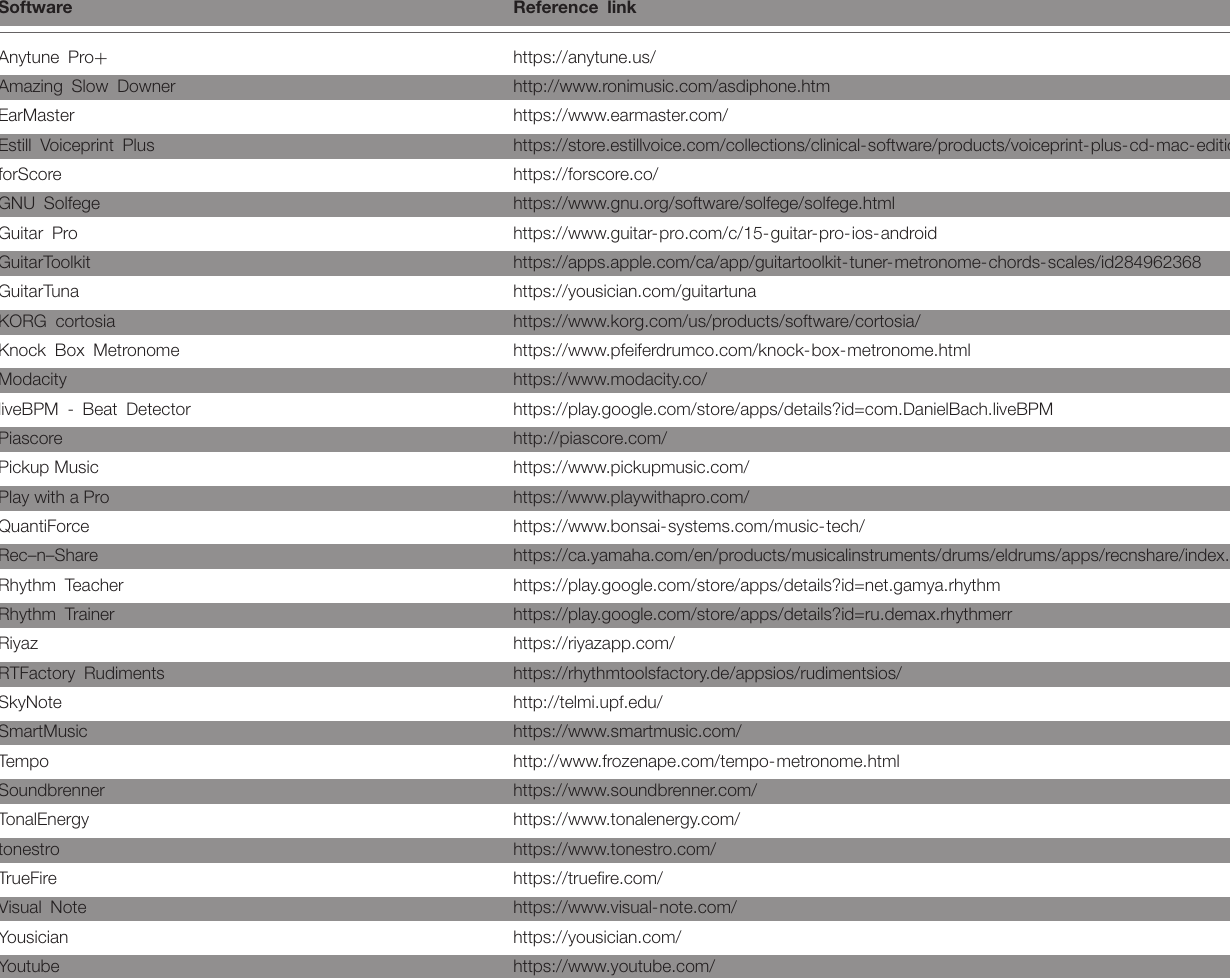
Table A1 | List of considered software with corresponding URL (accessed December 11, 2021).